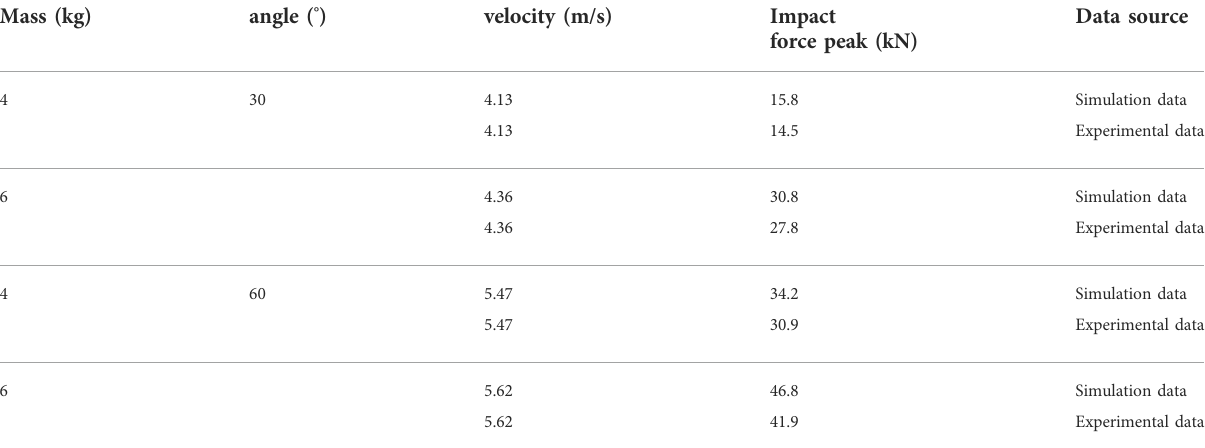
TABLE 2 Comparison of rolling stone impact force results.